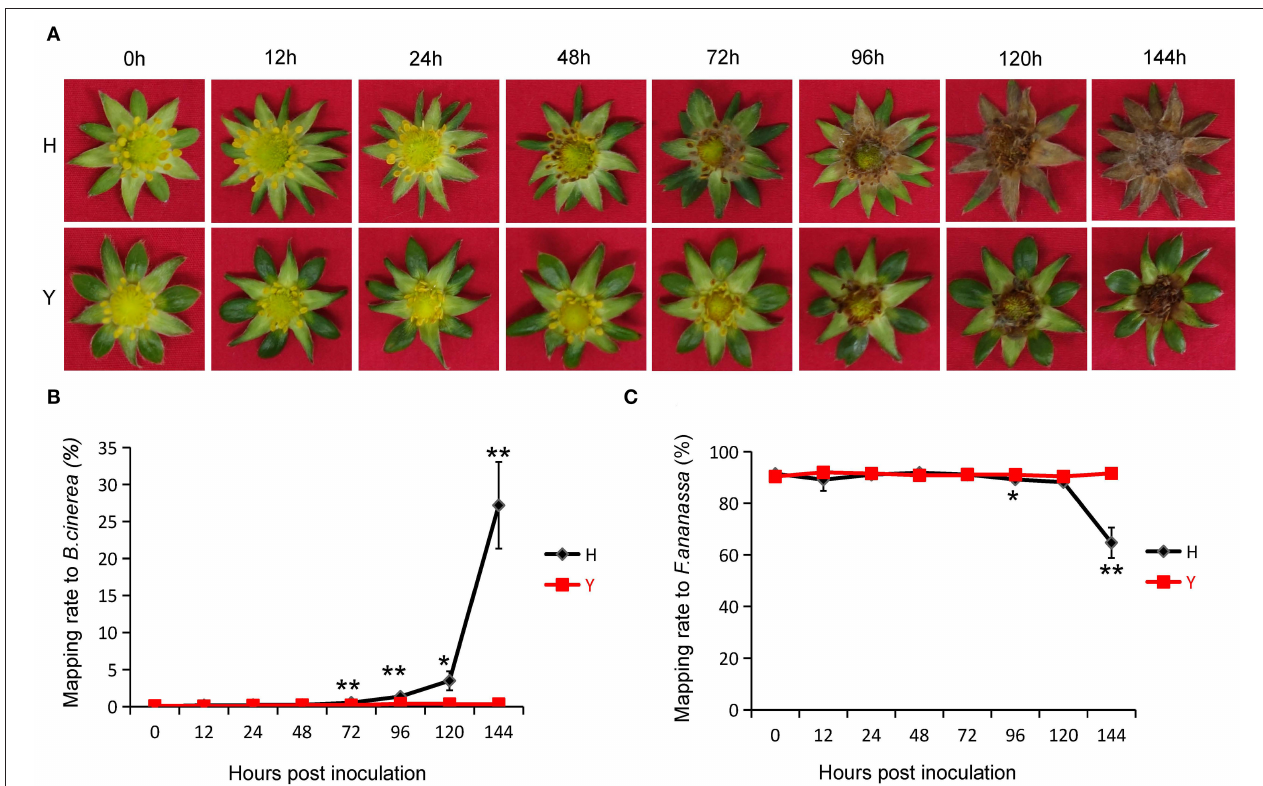
FIGURE 1 | Resistance of strawberry flower to Botrytis cinerea . (A) Disease symptoms of two cultivars, Y and Hongyan (H), displaying resistance and susceptibility to B. cinerea. (B) The ratio of successfully mapped reads to the genome of B. cinerea at 12, 24, 48, 72, 96, 120, and 144h post-inoculation (hpi). An average mapping rate (%) of a single time point has been presented. Error bars indicate standard error within three biological replicates. Statistically significant differences between cultivars for each time point are indicated by one asterisk ( p < 0.05) or two asterisks ( p < 0.01). (C) The ratio of successfully mapped reads to the genome of cultivated strawberry at all eight time